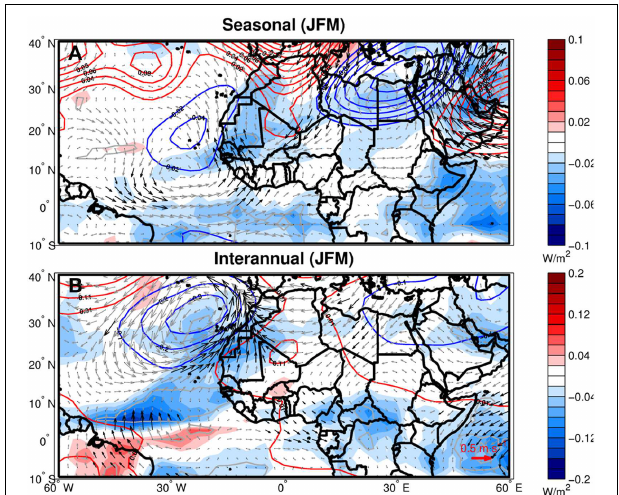
FIGURE 4 | Regression maps in winter (JFM) between Saloum rainfall index with OLR (shaded, W/m²), geopotential height at 400hPa (red: positive and blue: negative contours, m) and 400hPa winds (vectors, m/s) for: (A) Seasonal; (B) Interannual time scale. Gray contours delimit areas where the OLR is significant at the 95% level using a Monte Carlo